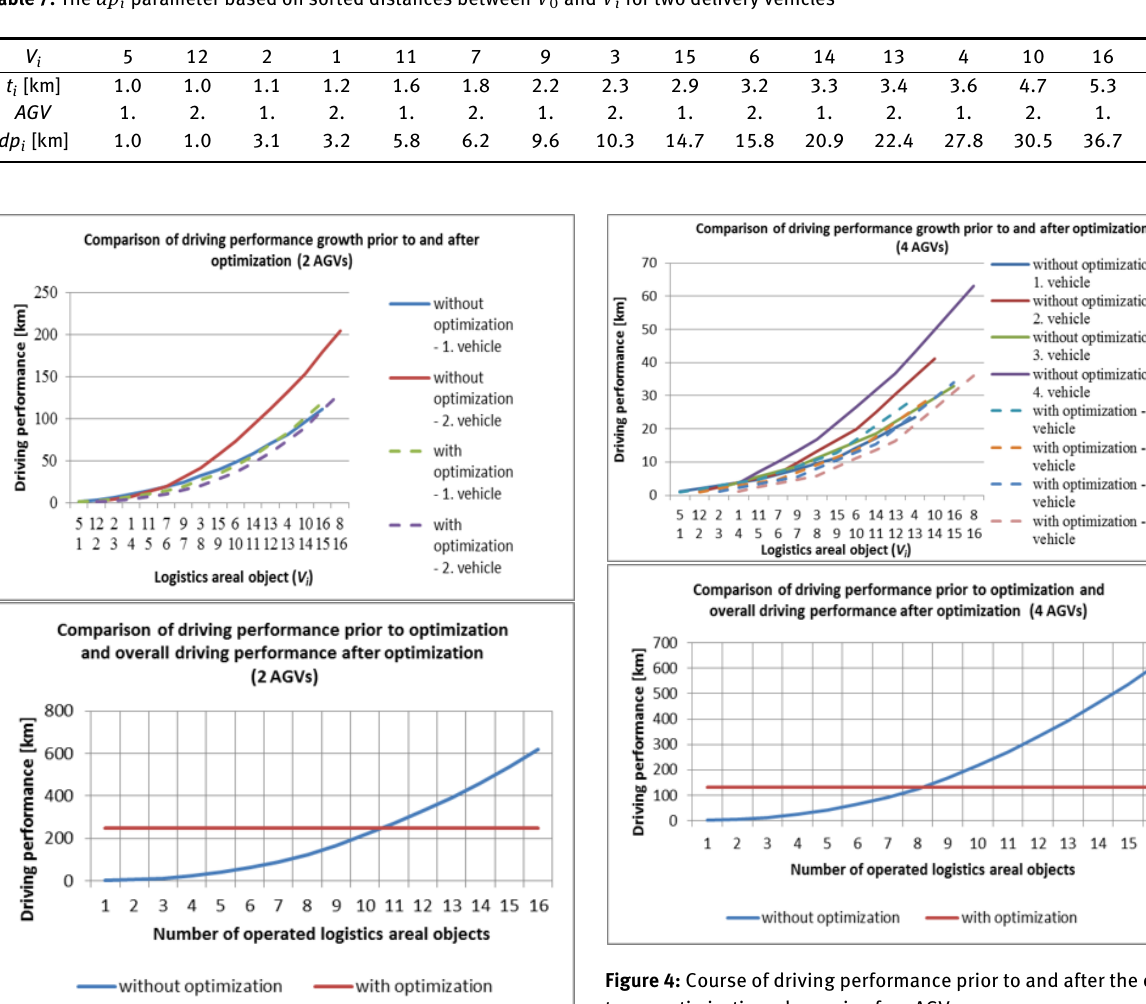
Table 7: The dp i parameter based on sorted distances between V 0 and V i for two delivery vehicles